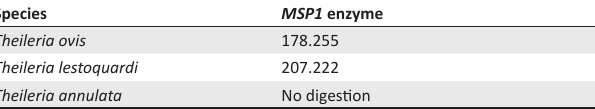
TABLE 2: Results of restriction enzyme on nucleotide sequences of different Theileria species in sheep. Species Theileria ovis